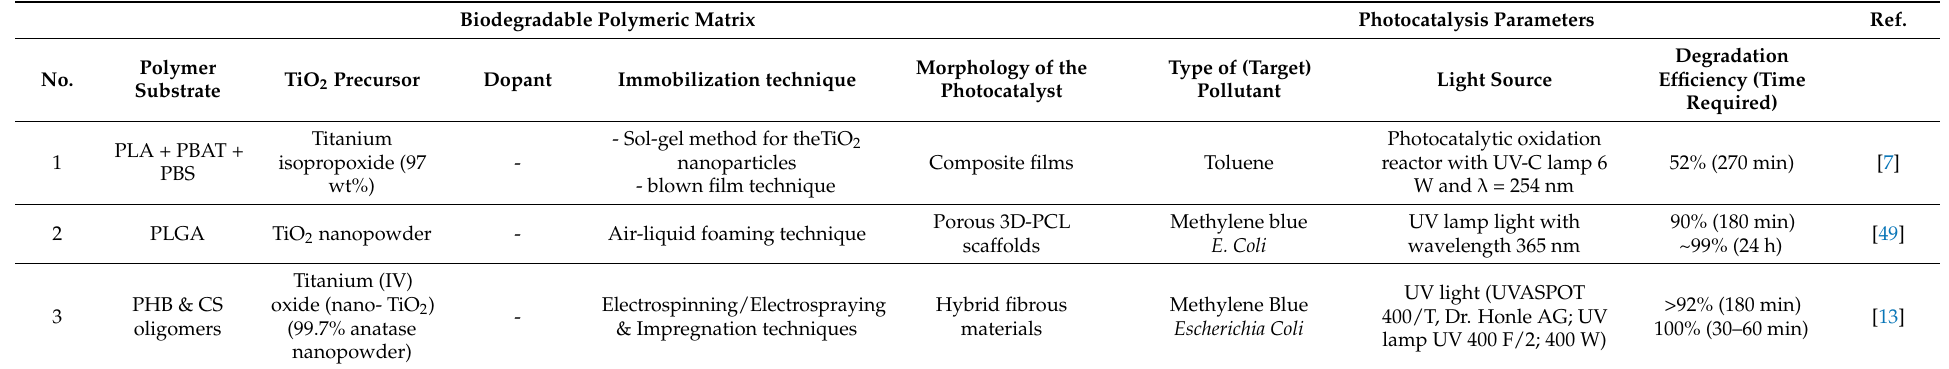
Table 6. Summary of other synthetic polymer-supported TiO 2 photocatalysts enclosed in the presented